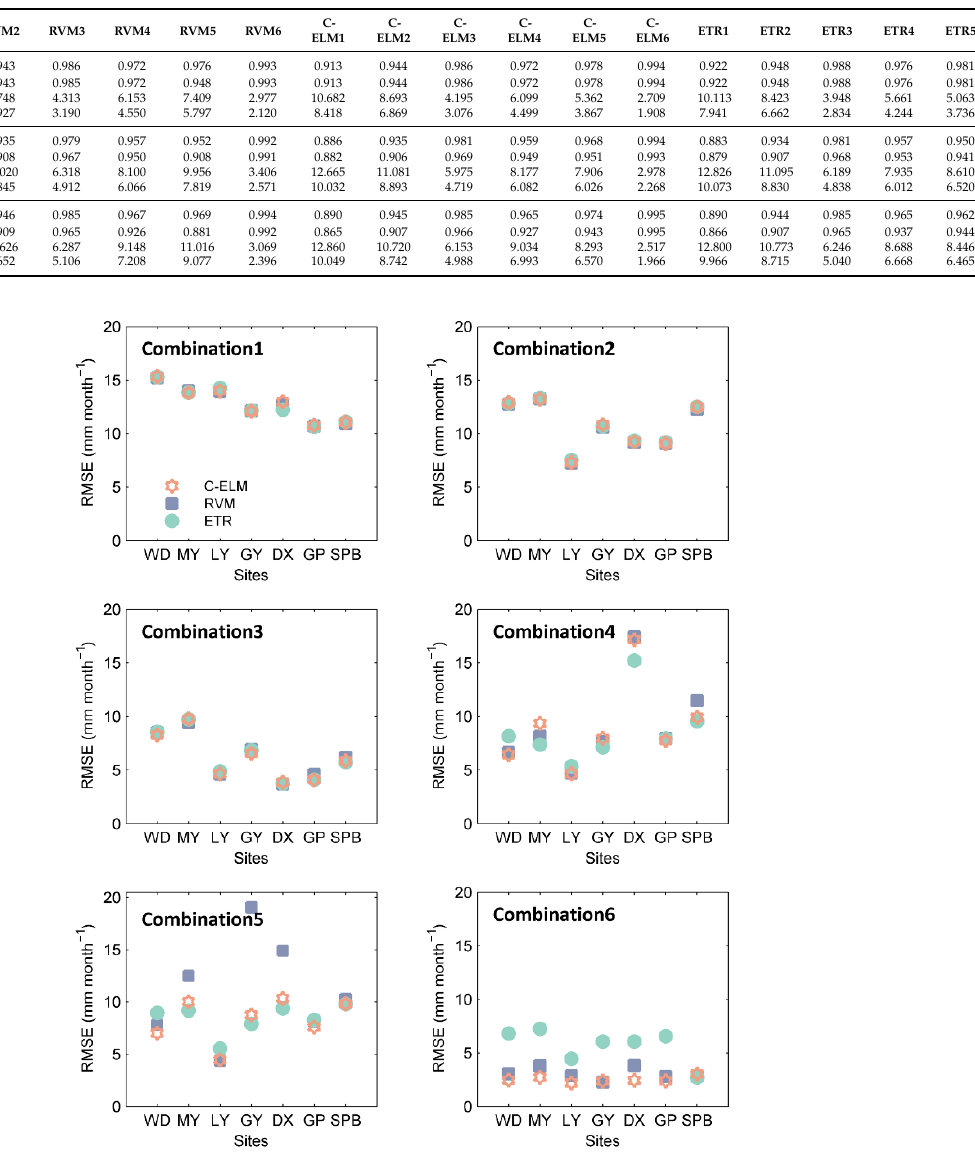
Table 4. Statistical indices for the RVM, C-ELM, and ETR models with six input combinations for modeling ET 0 during the training, validation, and testing periods.